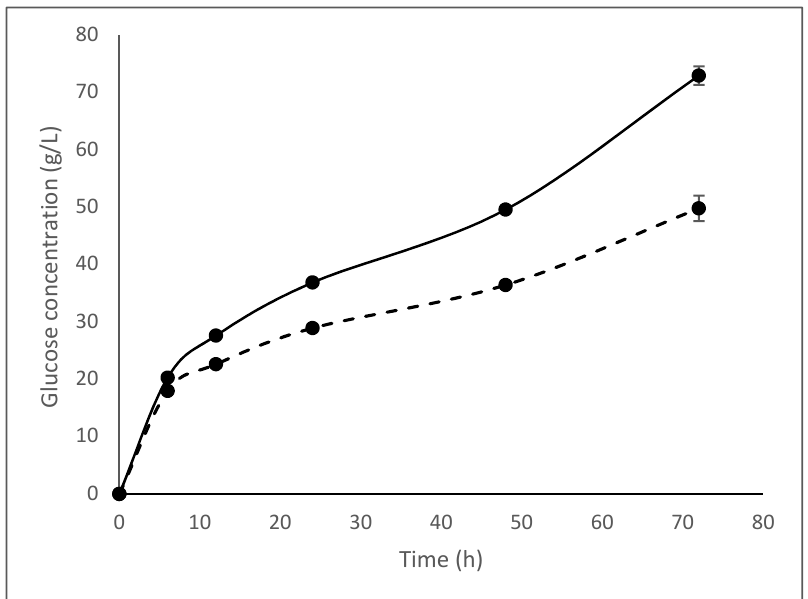
Figure 4. Glucose-concentration kinetics of lignin effect on enzymatic hydrolysis of Avicel at 10% solid loading. ( ― ) Control; (- -) 35.39% Lignin.